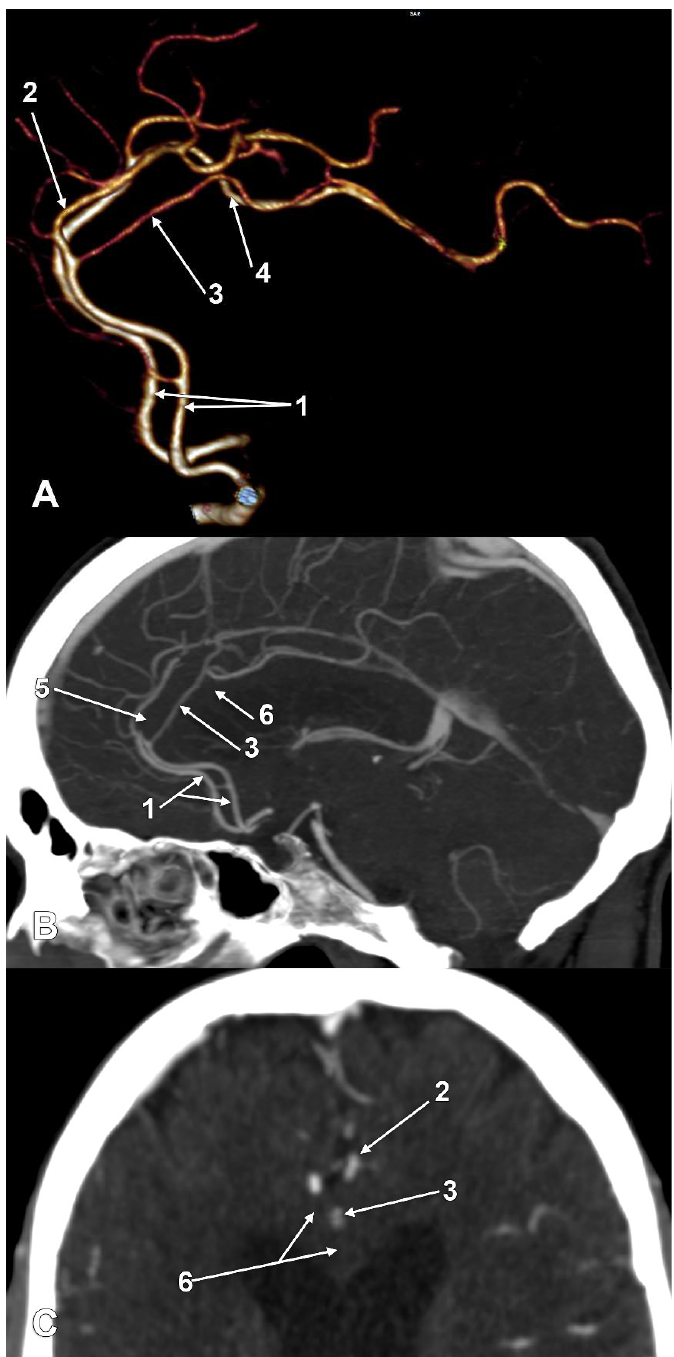
type 4 left CMA, at the level of the cingulate sulcus; 4. type 8 left PCalA. ( C ) Right lateral view: 1. A2 segments of the ACAs; 2. left type 1 CMA; 3. left type 1 PCalA; 4. right type 1 CMA, type 7 (absent) right PCalA. ( D ) Right lateral view: 1. A2 segments of the ACAs; 2. type 3b of the right CMA; 3. type 2b of the right PCalA. ( E ) Right antero-lateral view: 1. A2 segments of the ACAs; 2. type 2a of the left PCalA; 3. type 3a of the left CMA; 4. type 3 of the right PCalA; 5. type 2 right CMA. ( F ) Right lateral view: 1. A2 segment of the left ACA; 2. left type 1 PCalA; 3. left type 1 CMA; 4. type 2a right PCalA; 5. type 3a right CMA.